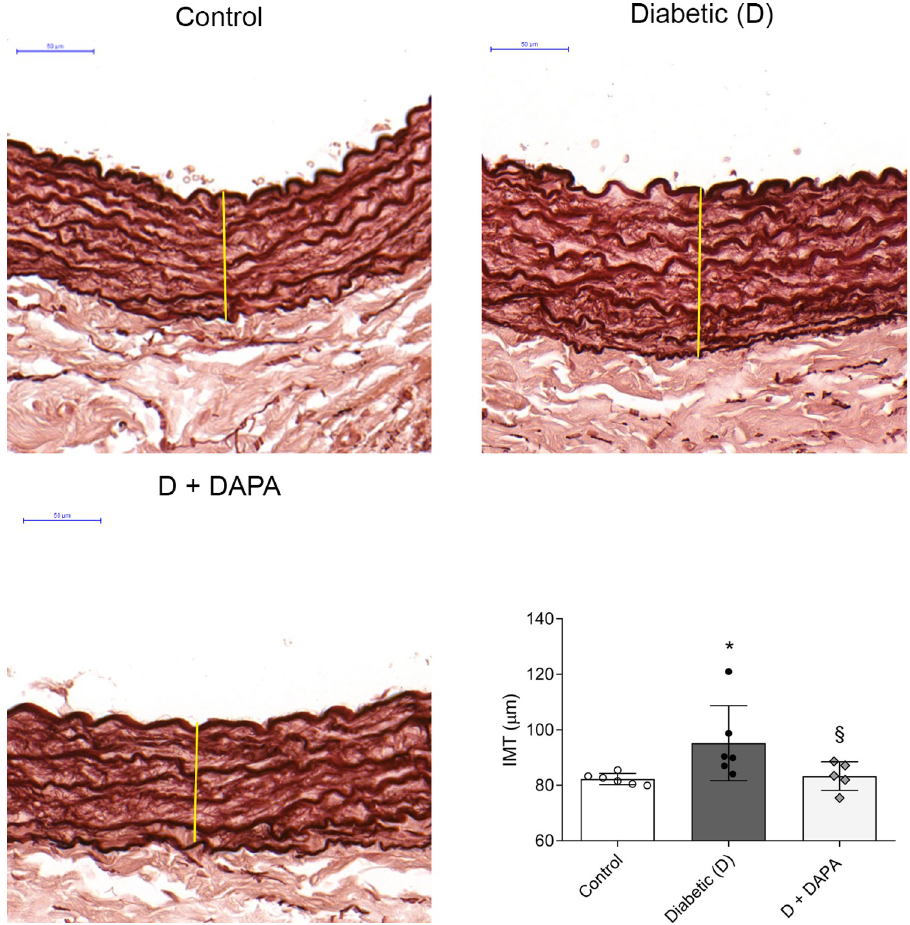
Fig 1. Intima-media thickening is prevented by dapagliflozin. Representative orcein stained aorta sections and quantitative evaluation of intima-media thickness (IMT) of control, diabetic (D) and dapagliflozin treated diabetic rats (D+DAPA). Original magnification, x200. Scale bar, 50 μ m. Elastic fibers are stained brown after orcein staining. They are visualized as either thin fibers or elastic lamella. Bars indicate means ± SDs and data were analyzed by one-way ANOVA with Holm-Sidak multiple comparisons test (n = 6/group). � p < 0.05 vs . Control, § p < 0.05 vs .